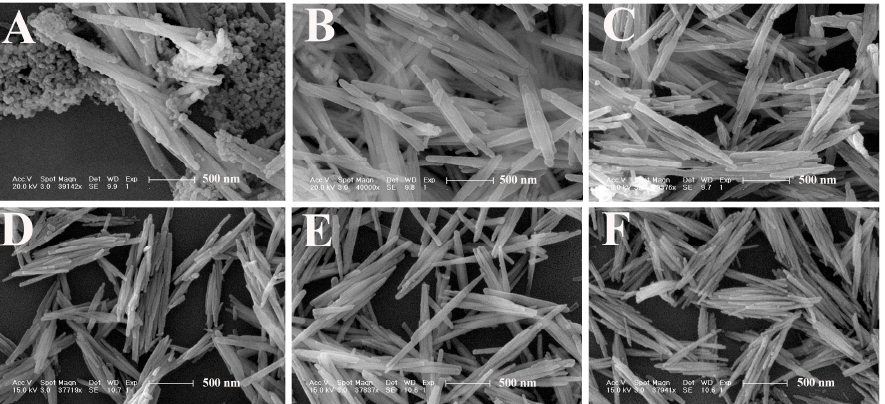
Figure 1. SEM of GdPO 4 ·H 2 O@SiO 2 synthesized with ratios of m GdPO4·H2O :V TEOS (mg/mL) = 1:8 ( A ), 4:5 ( B ), 1:1 ( C ), 5:4 ( D ), 5:3 ( E ) and 5:2 ( F ).